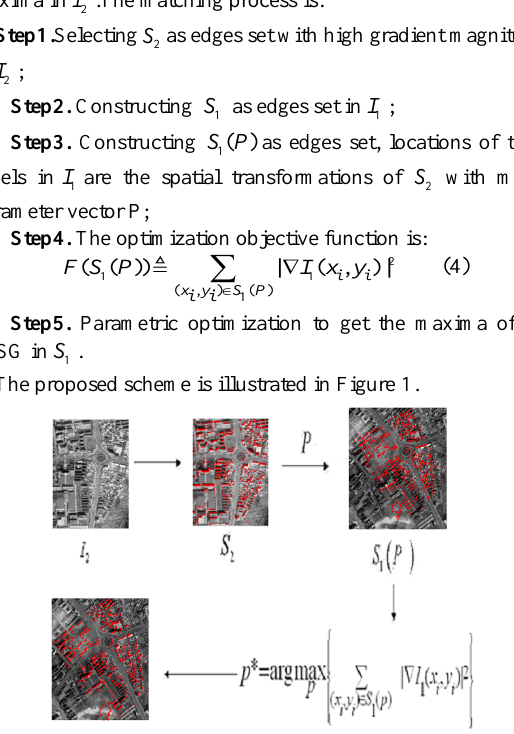
Figure 1.The sketch map of matching